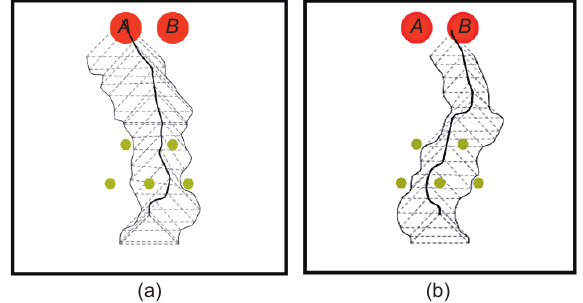
Fig. 11 Trajectories of multi-robot formation for a subject. (a) Result of the task where the subject was required to reach the target position A and the formation is enlarged. (b) Result of the task to go to the target position B and the formation is